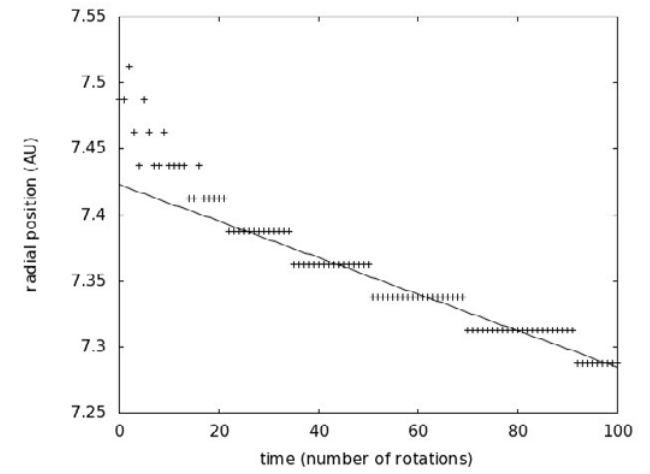
Figure 2. Radial position of the vortex as a function of